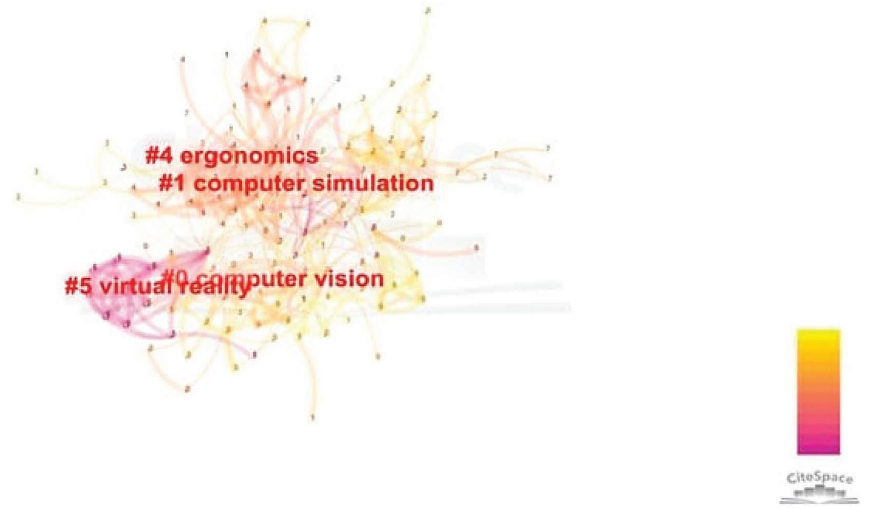
Figure 4: Cluster analysis